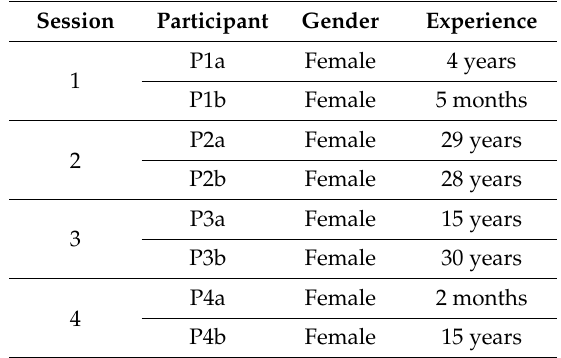
Table 1. Information about the different sessions, nurses and years of experience. Session Participant